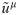
Model of structural plasticity and consolidation.
A, State/transition model of a single potential synapse (see text for details). B, In the following we consider potential synapses in a network W, for example, connecting two cortical neuron populations u and v. Memories correspond to associations between activity patterns u
μ and v
μ. We will specifically analyze how well noisy activity patterns u˜μ can reactivate the corresponding memories v
μ in order to estimate storage capacity. C, D: LTM storage (solid) by structural plasticity requires repetitive reactivation of activity patterns in cortical populations u and v to provide an appropriate consolidation signal S to the synapses. This may happen by repeated bottom-up stimulation (D) or, for episodic memories, by top-down replay (C) from a HC-type STM buffer (dashed). LTM = long-term memory; STM = short-term memory; HC = hippocampus.